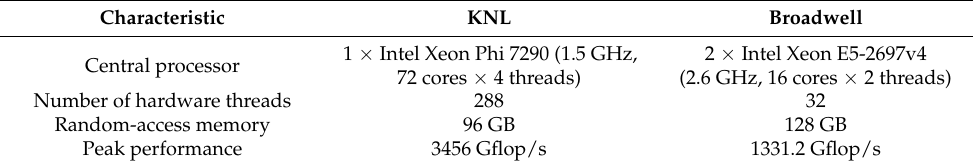
Table 1. Parameters of the Intel KNL and Broadwell computational nodes.